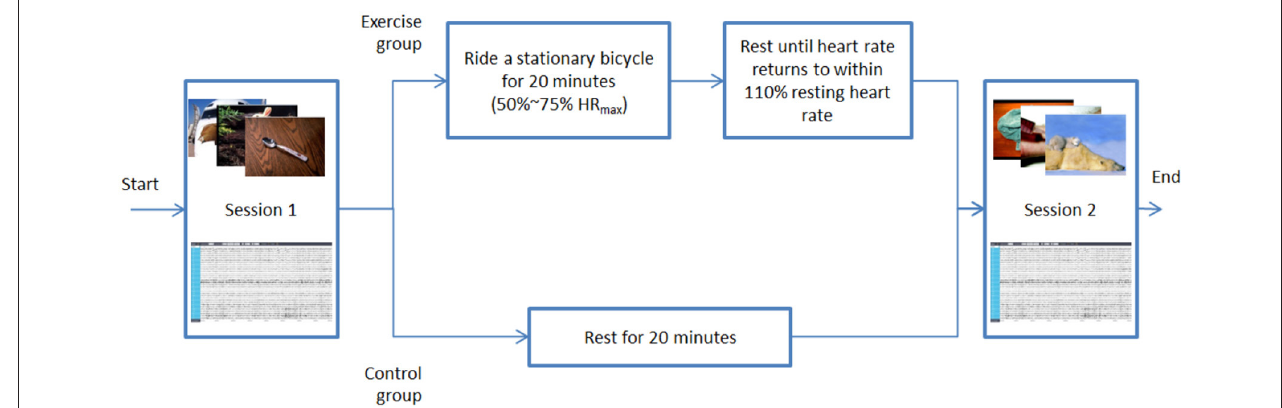
FIGURE 1 | The procedure of the proposed experiment.